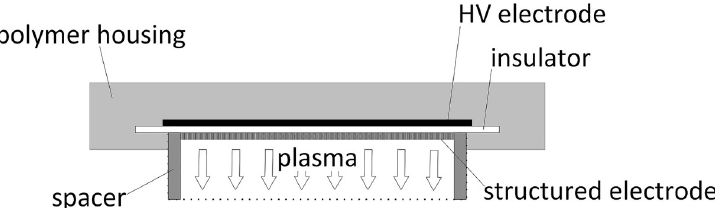
Fig 1. Schematic view of the plasma source prototype with surface micro-discharge-technology (SMD) in thin- film design. Ambient air is used and an area of interest of 12.56 cm 2 can be